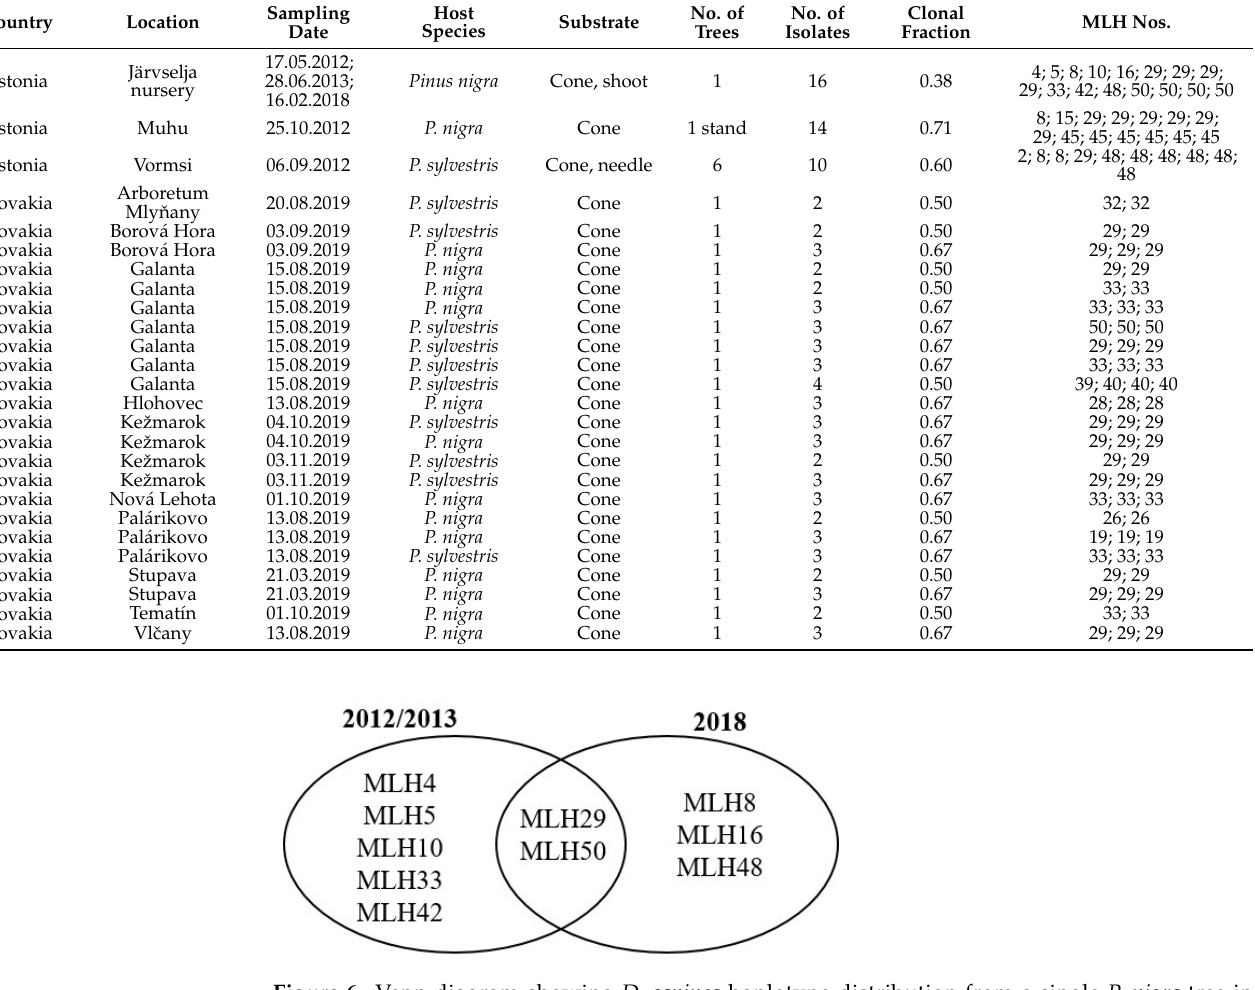
Figure 6. Venn diagram showing D. sapinea haplotype distribution from a single P. nigra tree in Järvselja nursery, Estonia from two sampling Järvselja nursery, Estonia from two sampling dates.